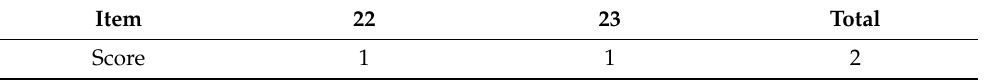
Table 5. Anna’s scores on the two items of the subcomponent Leisure/Recreation (LR). Item